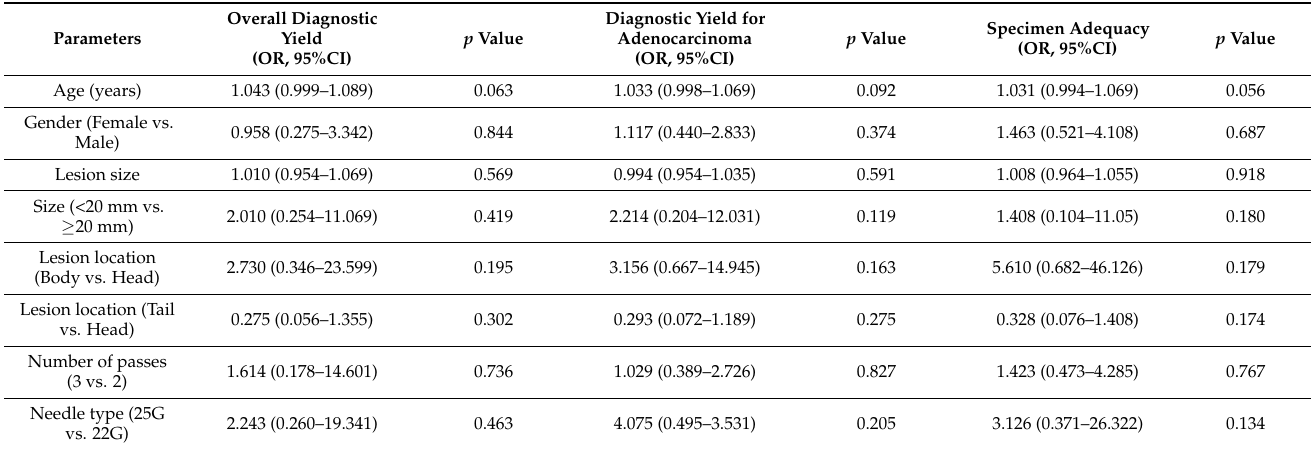
Table 2. Multivariate analysis of factors associated with overall diagnostic yield, diagnostic yield for adenocarcinoma and specimen adequacy. OR, 95%CI: odds ratio with 95% confidence